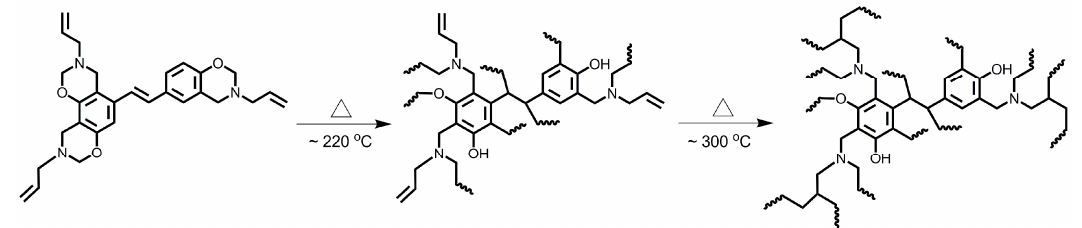
Scheme 2. Schematic representation of proposed thermally activated polymerization processes of